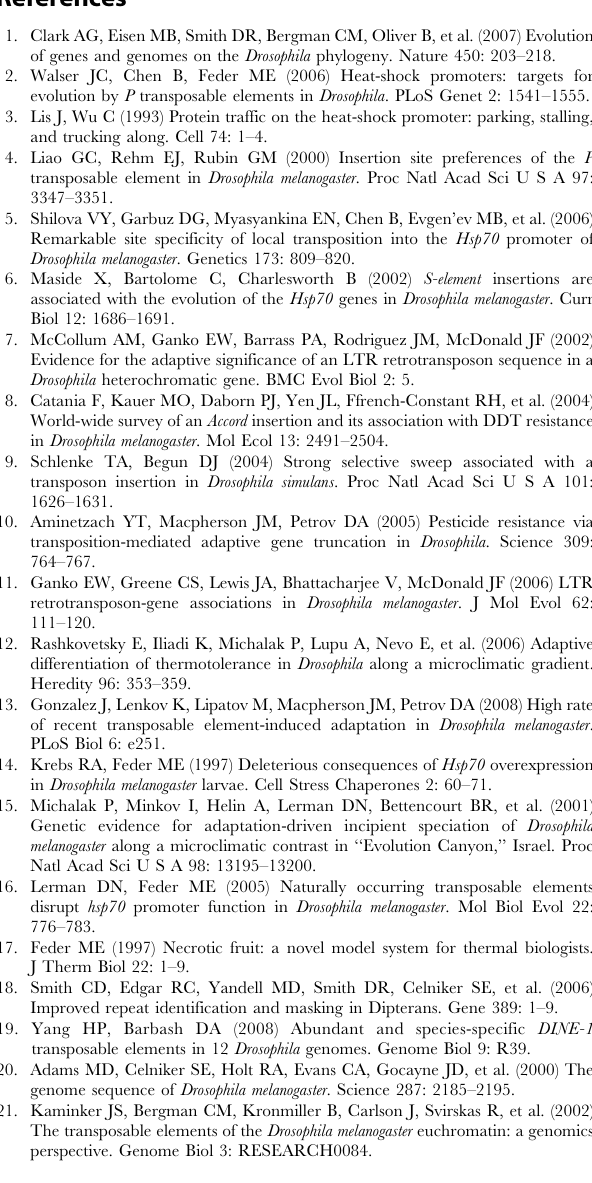
in the defined promoter region. The identity of the TE is listed along with TE class (retrotranposon = I, DNA transposon = II). Table S3 TE insertions per bp in each promoter set and 3-way G- test results at three levels of species sampling. Liberal, semi- conservative and conservative refer to method of estimating promoter set target size. Table S4 Number of orthologues of D. melanogaster heat-shock genes in each Drosophila species Found at: doi:10.1371/journal.pone.0008486.s004 (0.02 MB XLS) Table S5 Genomic location of TE insertion sequence in Drosophila promoters. For each insertion, in all promoters in which it is found, the genomic coordinates of both the promoter region